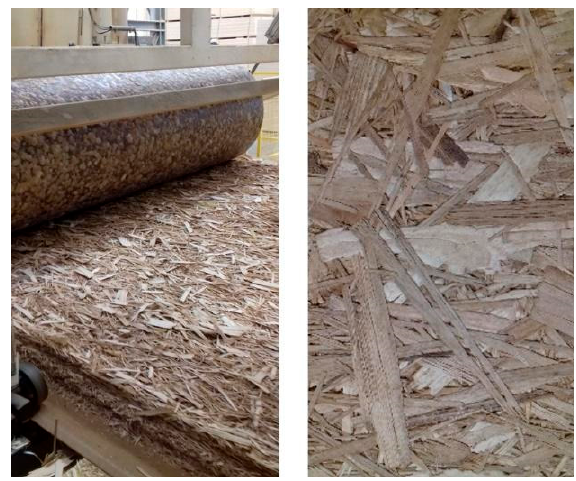
Figure 1. Strand mat before pressing ( left ) and detail showing the surface of a type B board (40% poplar, 60% sweet chestnut, right ).